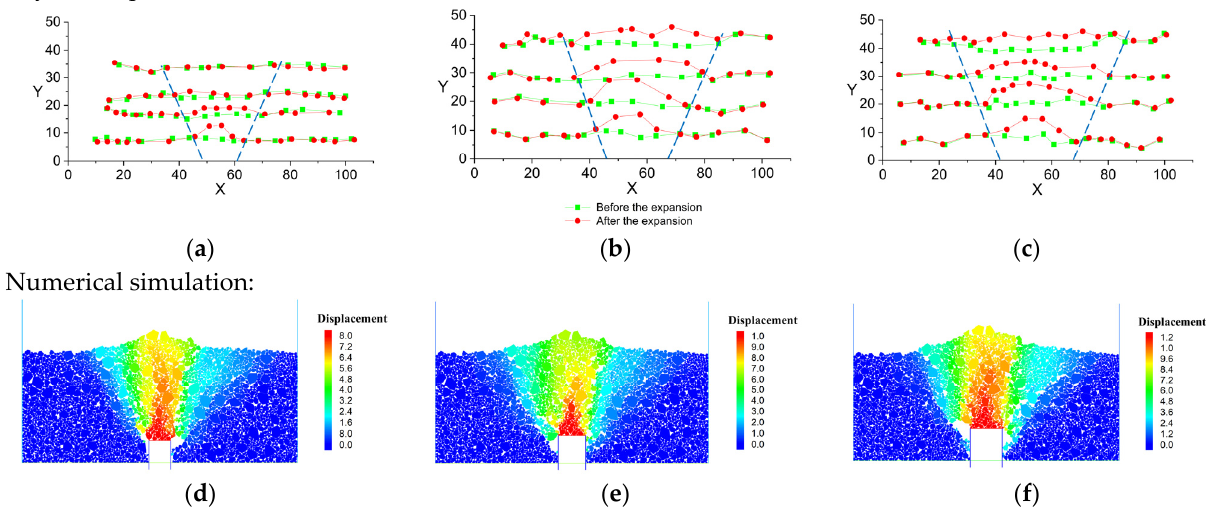
Figure 5. Displacement of collapse body under different expansion sizes: ( a ) the position of the mark particles when the expansion size is 80 mm; ( b ) the position of the mark particles when the expansion size is 100 mm; ( c ) the position of the mark particles when the expansion size is 120 mm; ( d ) the particles displacement when the expansion size is 0.8 m; ( e ) the particles displacement when the expansion size is 1.0 m; ( f ) the particles displacement when the expansion size is 1.2 m.